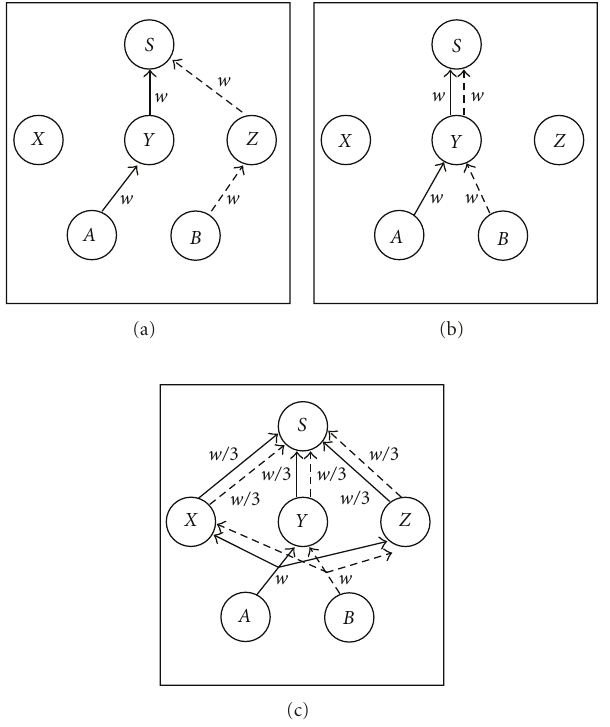
Figure 1: Forwarding examples: (a) normal forwarding with di ff erent next-hops; (b) normal forwarding with the same next-hop; (c) forwarding after splitting.